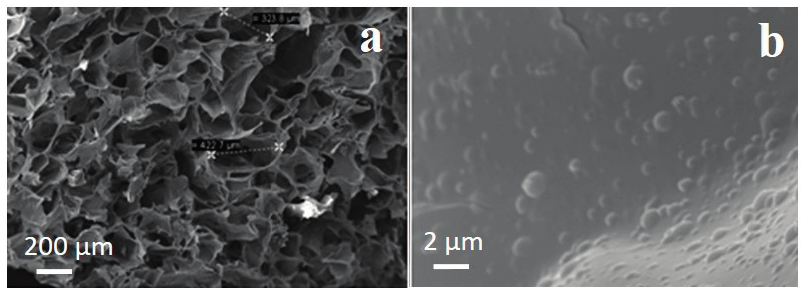
Figure 8. SEM images of ( a ) fractured sections of scaffolds embedding PLGA nanoparticles and ( b ) expanded section of ( a ) showing embedded nanoparticles. In the black boxes